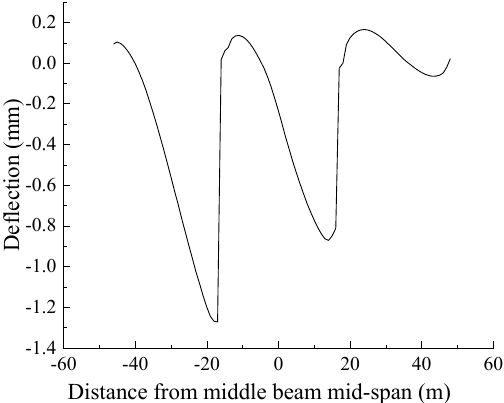
Figure 9. Longitudinal relative displacement of beam and base under static loading.